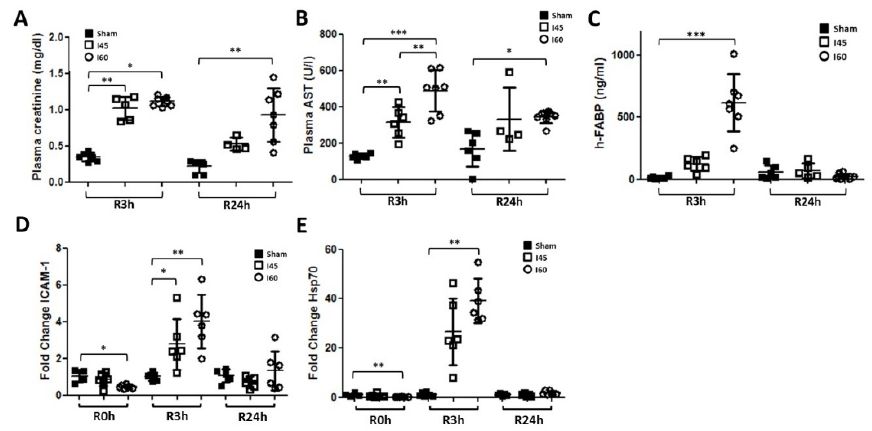
Figure 4. Kidney function is reduced and injury is increased following severe compared to mild or no ischemia. Rats, either Sham-operated (Sham) or subjected to 45 min (I45) or 60 min (I60) of renal ischemia, were sacrificed at various time points post reperfusion (R0h, R3h, and R24h). Plasma was collected to measure the creatinine ( A ), AST ( B ), and h-FABP ( C ). Kidneys were collected and analyzed for the mRNA expression of ICAM-1 ( D ) and Hsp70 ( E ). * p < 0.05, ** p < 0.01, *** p < 0.001. N =